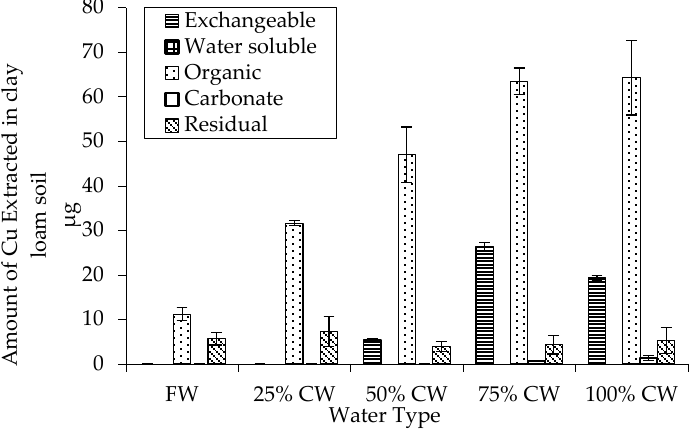
Figure 4. Mean amounts of fractions of Cu (in μ g) recovered in clay loam soil that had been irrigated with different concentrations of contaminated water.